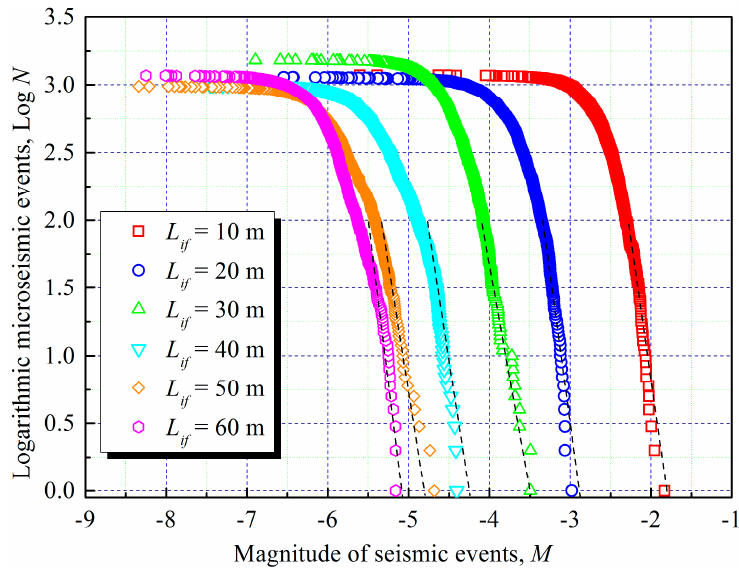
Figure 16. Relationship between the magnitude of seismic events and the logarithmic seismic events when the distance between the injection hole and the fault ranged from 10–60 m. Table 4. Fitting a - and b -values of the accumulated seismic events when the distance between the injection hole and the fault ranged from 10–60 m.